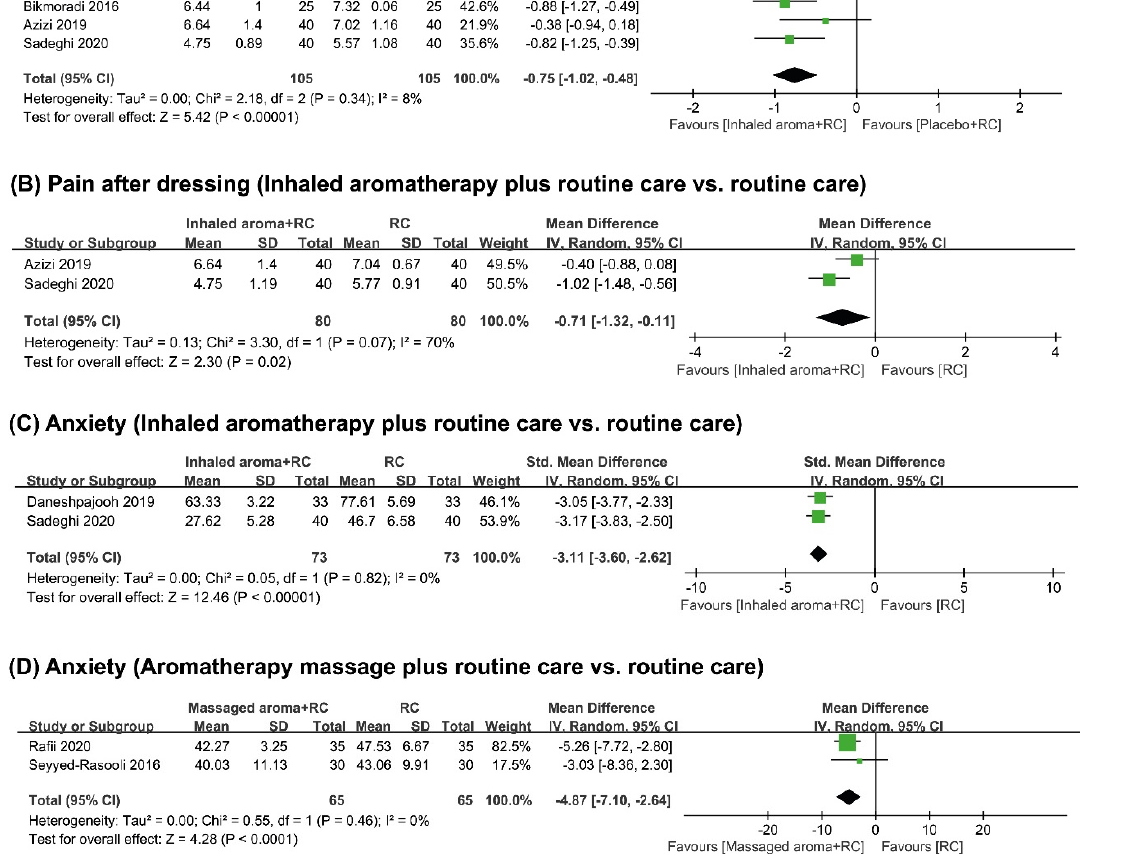
pain intensity after dressing while one study [26] measured the general pain